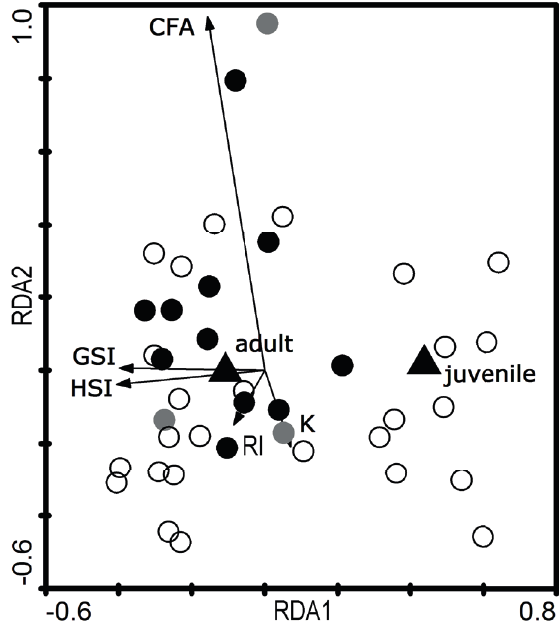
Figure 2. Partial Redundancy Analysis (RDA) showing the relationship of fl uctuating asymmetry (CFA) with four physiologica l indexes (GSI, HSI, RI, and K) of adult and juvenile Orthopristis ruber . ⚪ =Urca; ⚫ =Rio- Niterói Bridge; ⚫ =Paquetá; ▲ = grouping of adults and